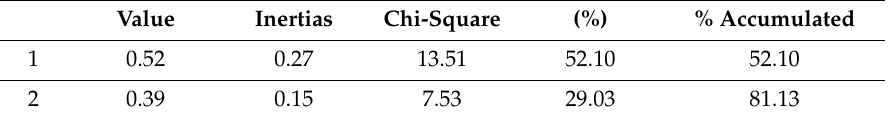
Table 5. Contribution to the Chi square of education and purpose of the